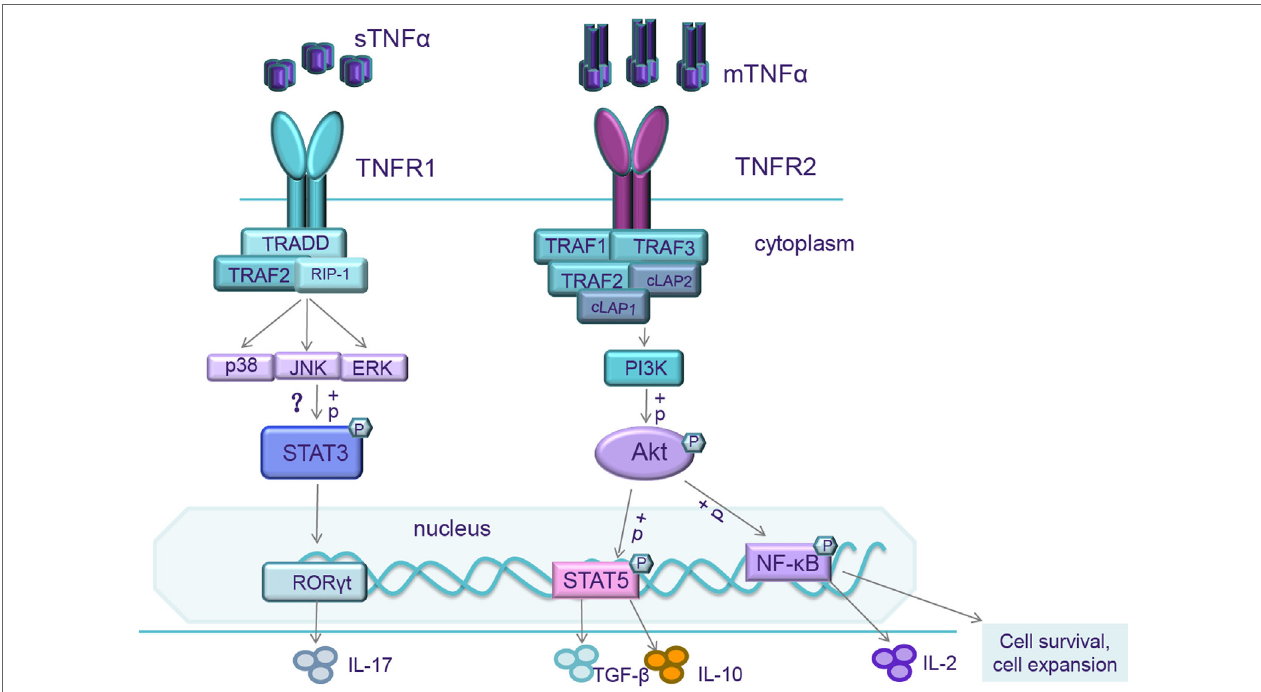
FiGURe 1 | When mTNF/TNF receptor 2 (TNFR2) is activated, the intracellular domains recruit existing cytoplasmic TNF receptor-associated factor-2 (TRAF-2)–cIAP-1–cIAP-2 complexes resulting in the initiation of both canonical and non-canonical NF- κ B/Rel and MAPK pathways activation. NF- κ B/Rel and MAPK pathways activate IL-2 promoter and trigger IL-2 expression. NF- κ B pathways also transcript genes associated with cell survival and cell proliferation. So, mTNF/TNFR2 signaling can enhance expansion and stability of Tregs and increase Treg sensitivity to low level of IL-2. It also activates the reciprocal PI3K/Akt pathway. Activation of Akt signaling impairs Th17 differentiation, correlated with an increased phosphorylation of STAT5 (143). When soluble TNF α (sTNF α )/TNFR1 is activated, the intracellular domains interact with TRADD, which receptor interacting protein-1 (RIP-1) and TRAF-2 to form Signal complex I, then further triggering extracellular signal-regulated kinases (ERKs), p38, and c-Jun N-terminal kinase (JNK). The mechanisms of TNFR1 on Th17 differentiation are still unclear. These transcription factors might phosphorylate STAT3, upregulate the level of ROR- γ t, and increase IL-17 production. FiGURe 2 | When the TNF receptor 2 (TNFR2) signaling pathway is activated, it increases Tregs stability, responses to TCR stimulation, expansion, and function. It enhances Tregs and effector T cells to produce IL-2 and promotes the sensitivity of Tregs to IL-2. IL-2 can inhibit Th17 cells differentiation and the effect of TNFR2 signaling on Tregs. Under inflammatory condition, mTNFR2 can shed to sTNFR2, sTNFR2 neutralizes TNF and hampers IL-6 expression.